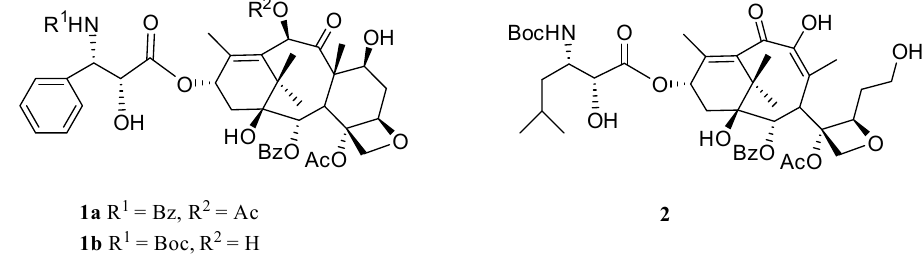
Figure 1. Structures of paclitaxel ( 1a ), docetaxel ( 1b ), and IDN5390 ( 2 ).